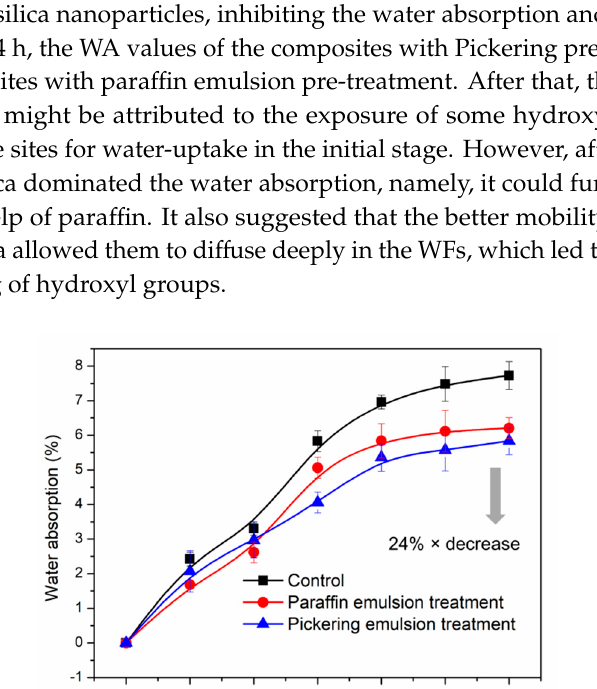
Figure 8. Mechanical properties of untreated (control) and emulsion treated WF/HDPE composites ( a ) tensile strength (TS) and impact strength (IS); ( b ) modulus of rupture (MOR) and modulus of elasticity (MOE).